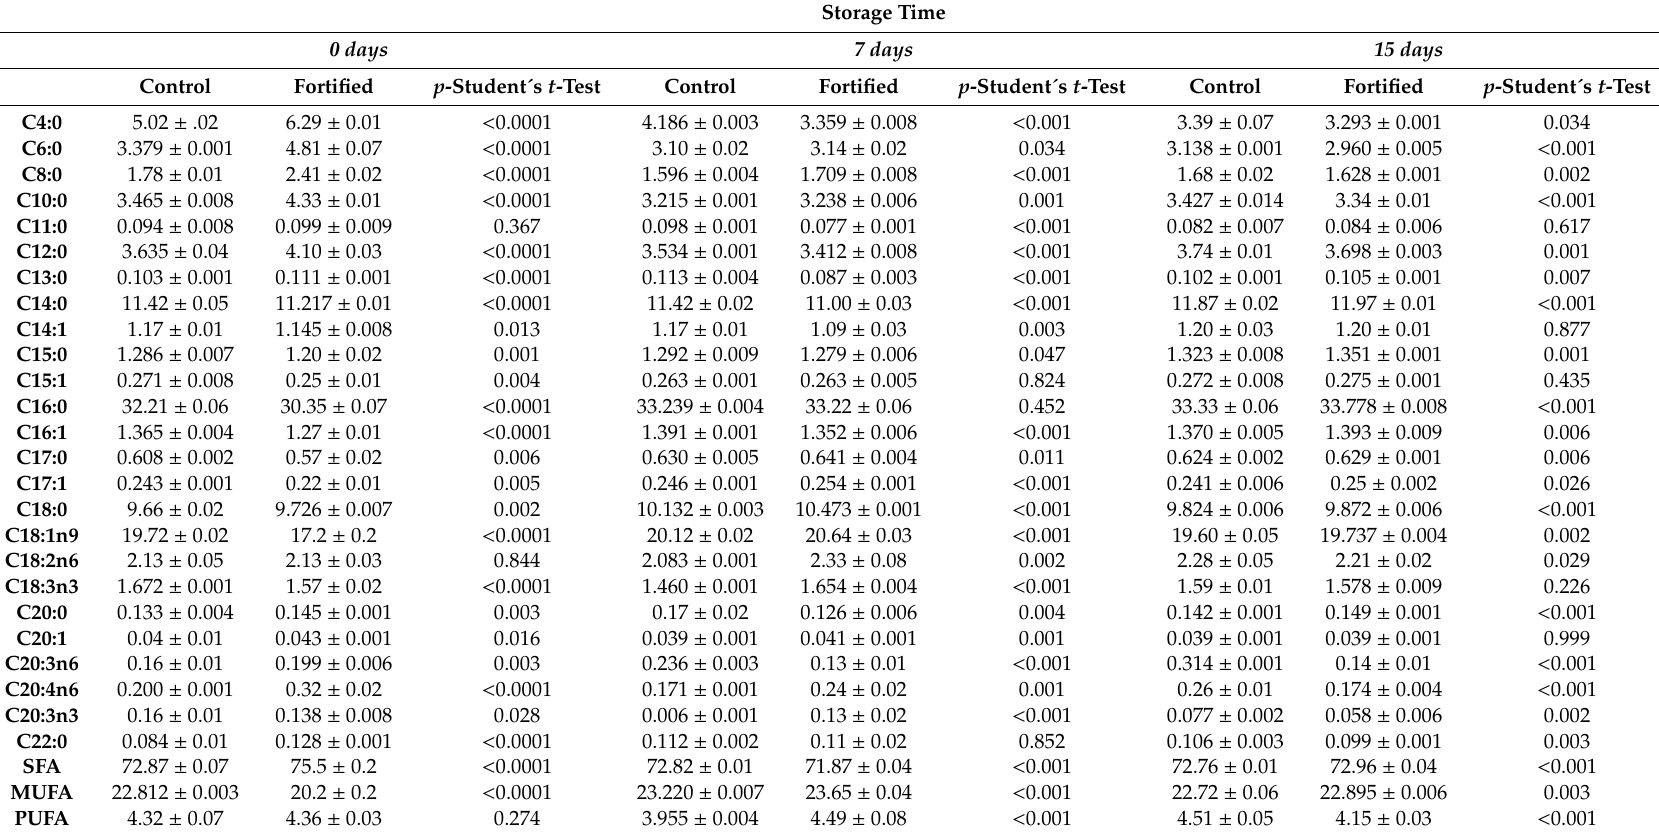
Table 5. Fatty acids composition of the yogurts, in relative percentage of each fatty acid, along shelf life. Storage